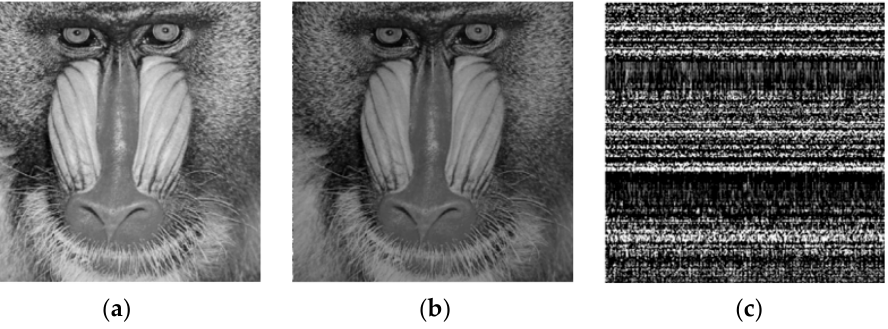
Figure 8. Key sensitivity analysis. ( a ) original image; ( b ) decrypted image using the correct decryption key; ( c ) decrypted image using incorrect decryption